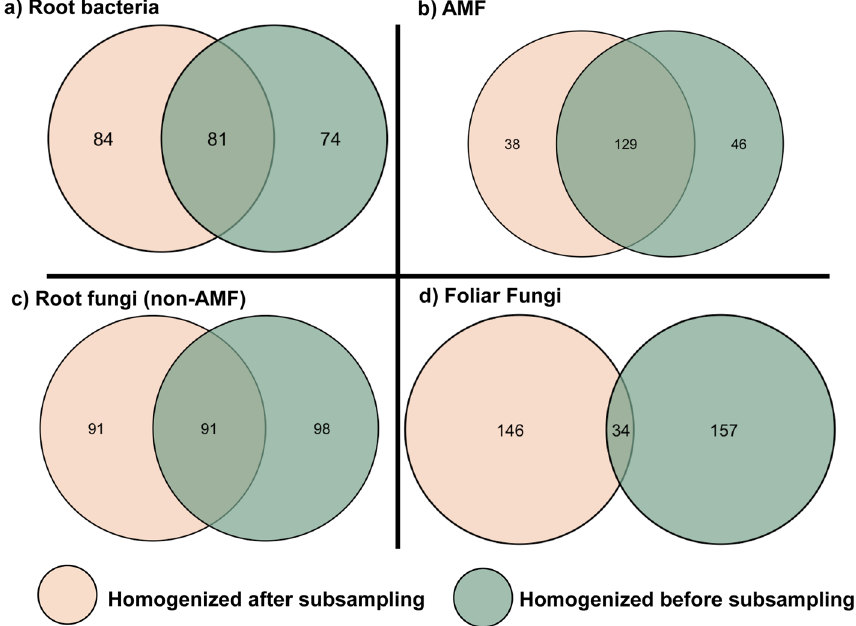
Figure 3. Venn diagrams showing the overlap of sequence variants (SVs) recovered from milkweed plants at a single site, when subsampling microbial communities using two different strategies.